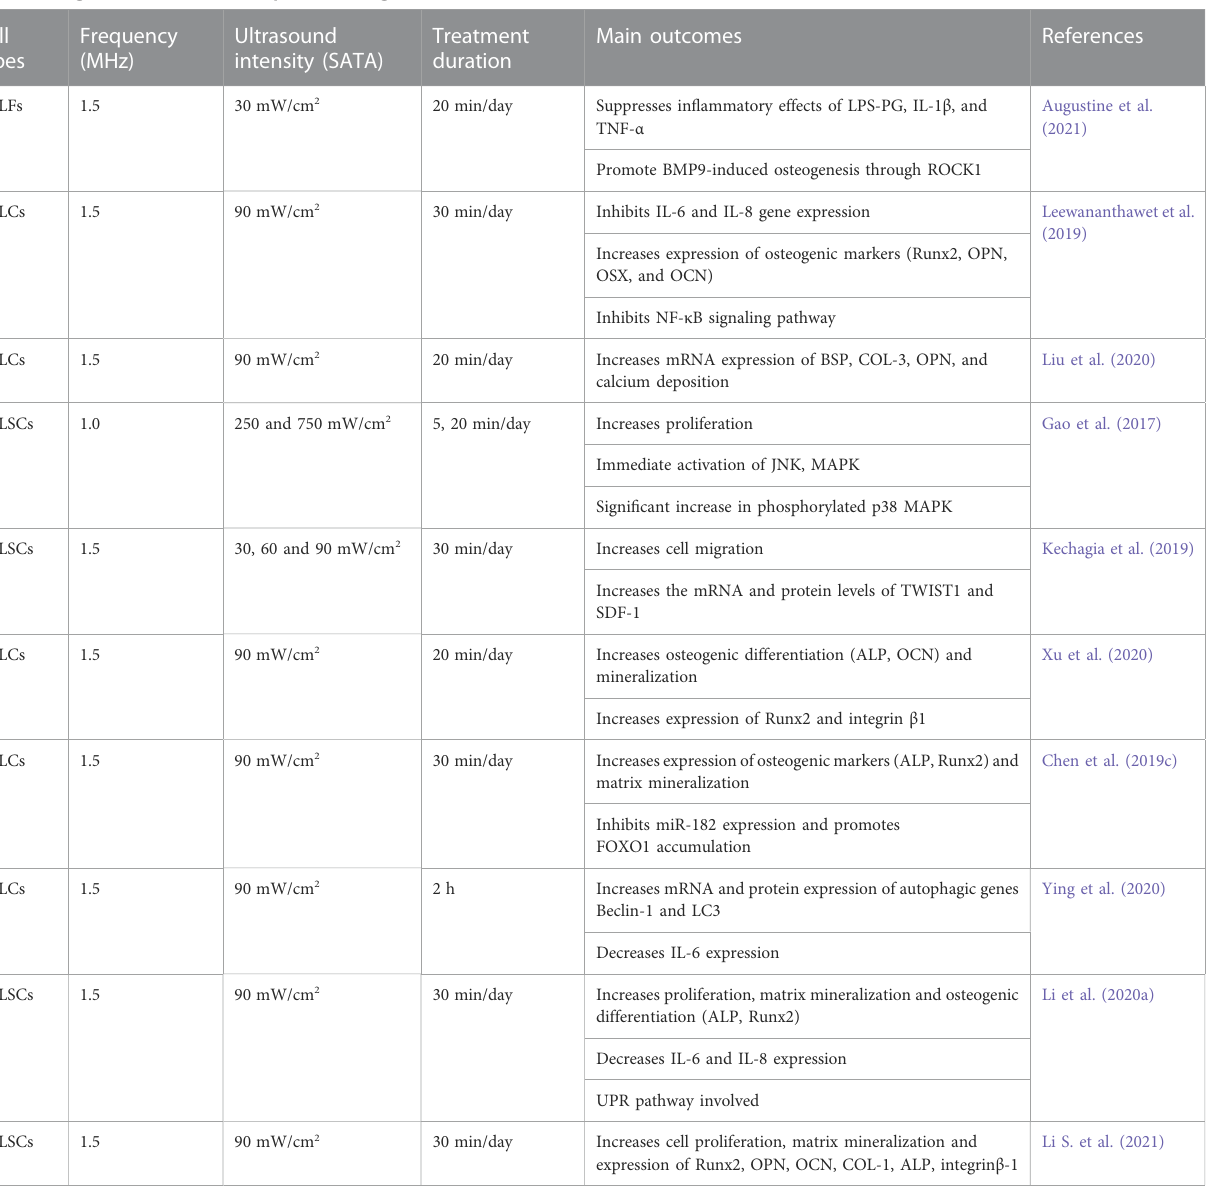
TABLE 1 Biological effects of LIPUS on periodontal ligament